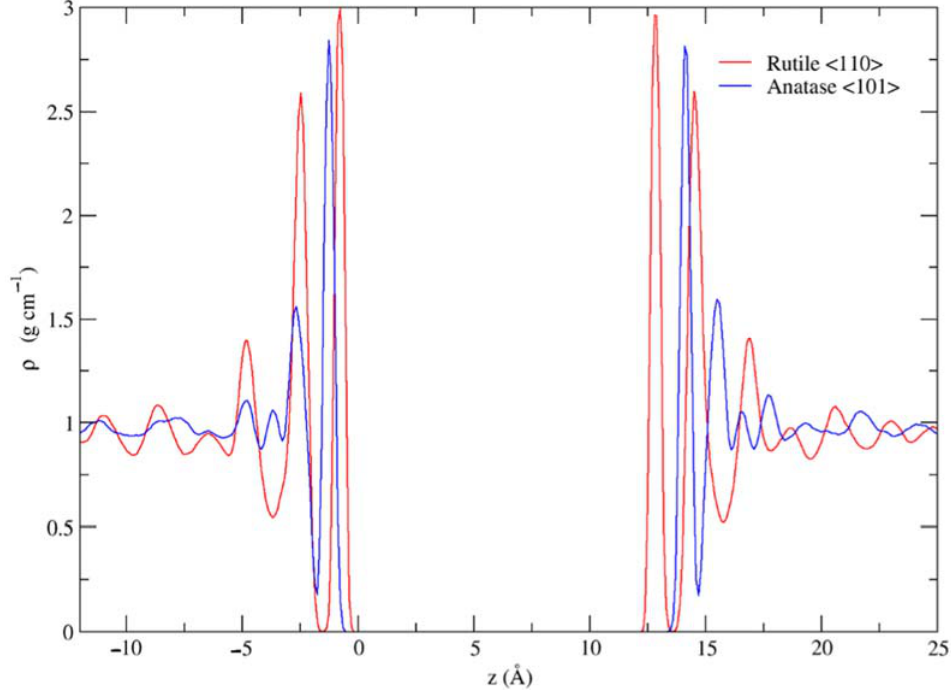
Figure 2. Density profile of adsorbed water molecules (g cm − 3 ) at TiO 2 surfaces along the z ‐